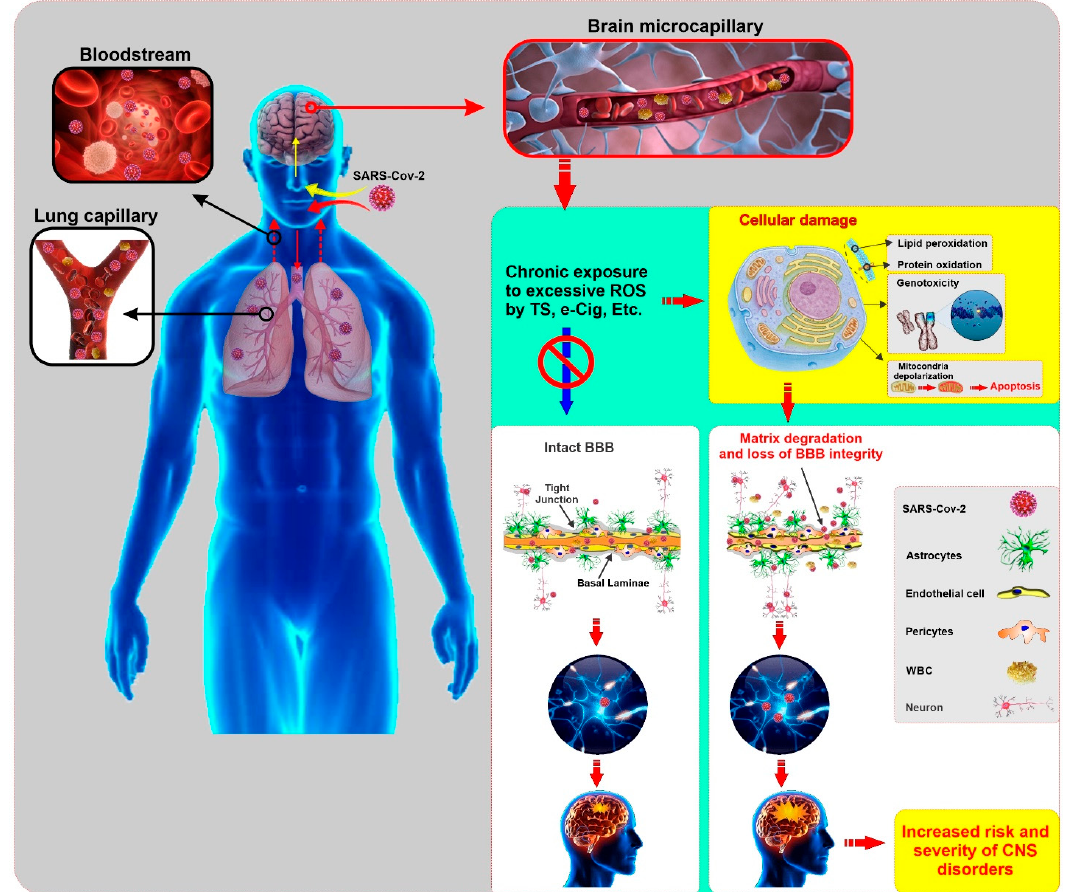
Figure 2. Illustrative panel summarizing the SARS-CoV-2 entry into the human body and the potential impact of comorbid smoking and/or vaping on the harmful effects of the viral infection to the CNS. Pre-existing conditions that impairs the viability and function of the BBB (such as those associated with chronic smoking and / or vaping) may facilitate viral entry into the brain, thus increasing the risk of onset and severity of CNS disorders. (ROS: Reactive Oxygen Species, TS: Tobacco Smoke,